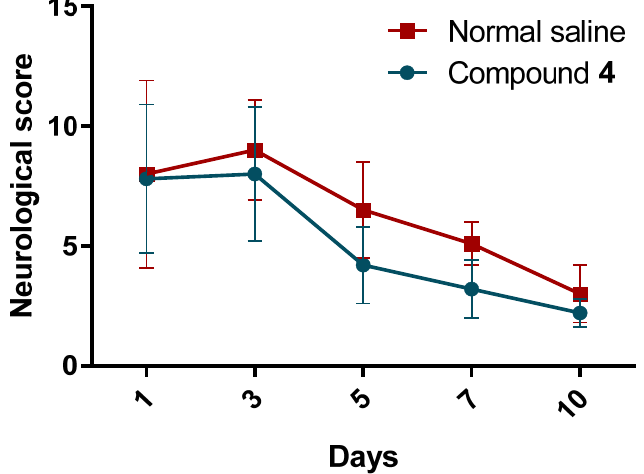
Figure 4. Neurological deficit. Neurological deficit was measured in rats treated with normal saline and Compound 4 . Rats were exposed to different tests and the final performance score per animal was recorded. Compound 4 —green. Normal saline—red. The mean and SD of the neurological score are presented. Two ‐ way ANOVA was used for significance calculation.